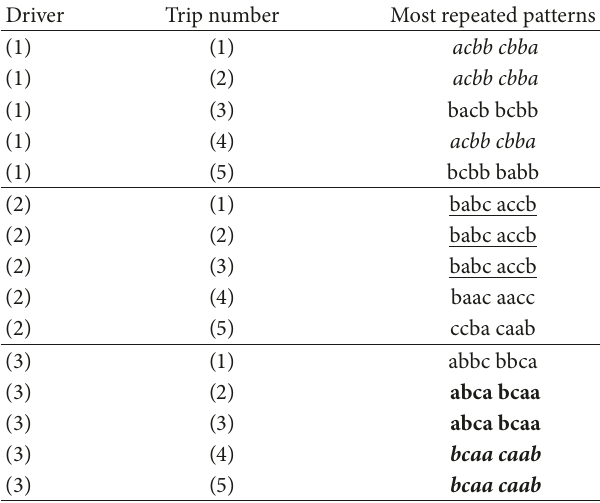
Table 2: Initial results of applying motif discovery algorithm to driving signals. It was found that each of the three driver has his own characteristic as they all have unique most repeated